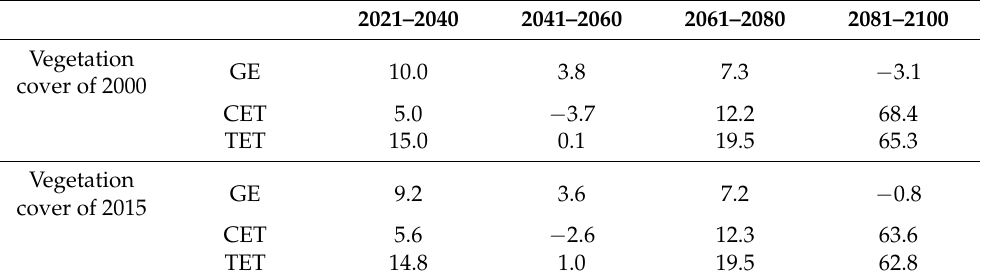
Table 2. Quantified contribution of climate change to ET in different stages during 2021 − 2100 on the